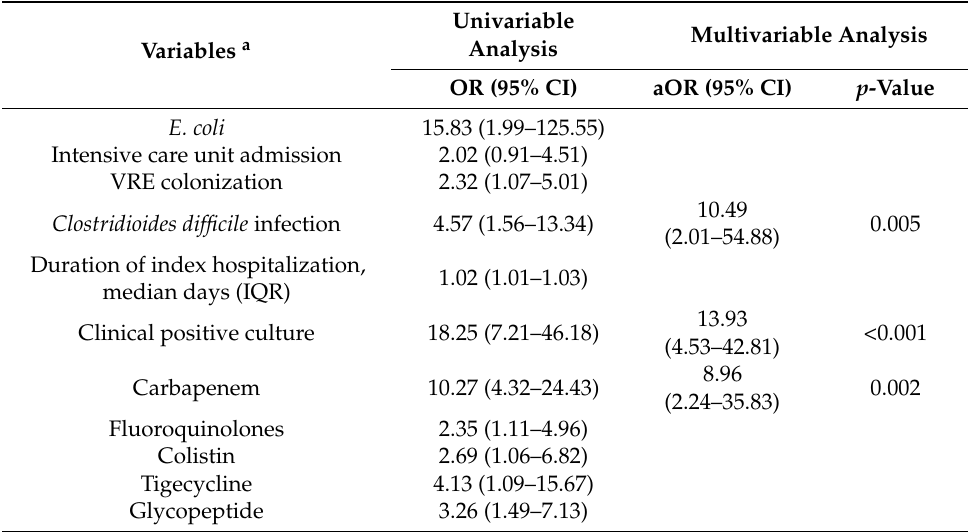
Table 3. Univariable and multivariable analyses of risk factors for prolonged carriage after 3 months among the selected patients with OXA-48-like-producing CRE colonization ( n = 116).